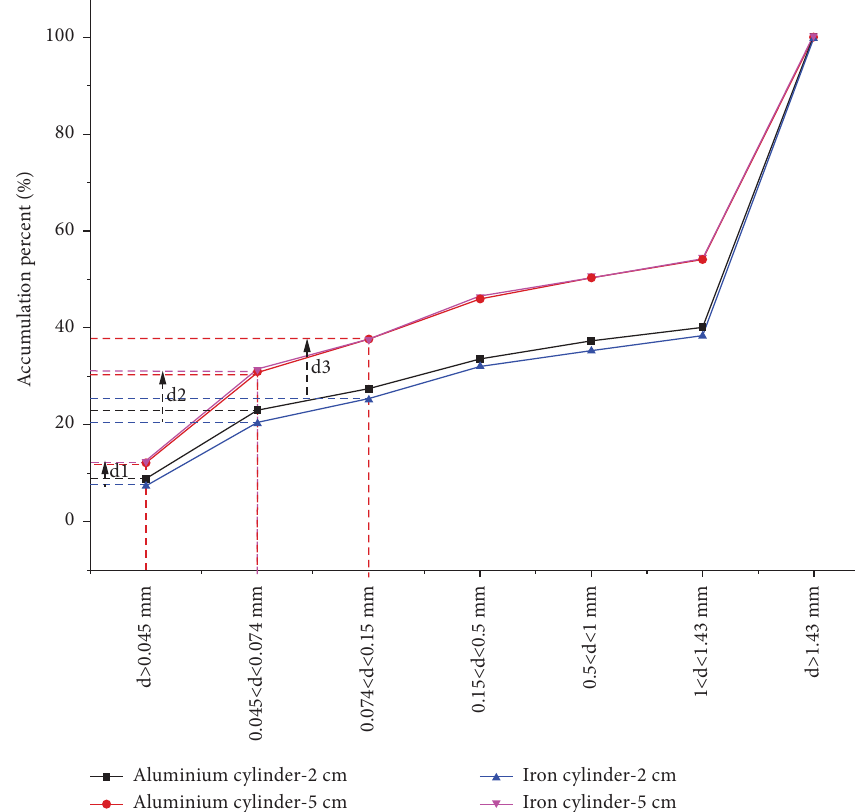
Figure 4: Comparison of the pulverization efects of mass blocks of diferent lengths and materials. Table 2: Te quality of the bauxite ore in the frst group of circulating experiments. Bauxite ore for experiments